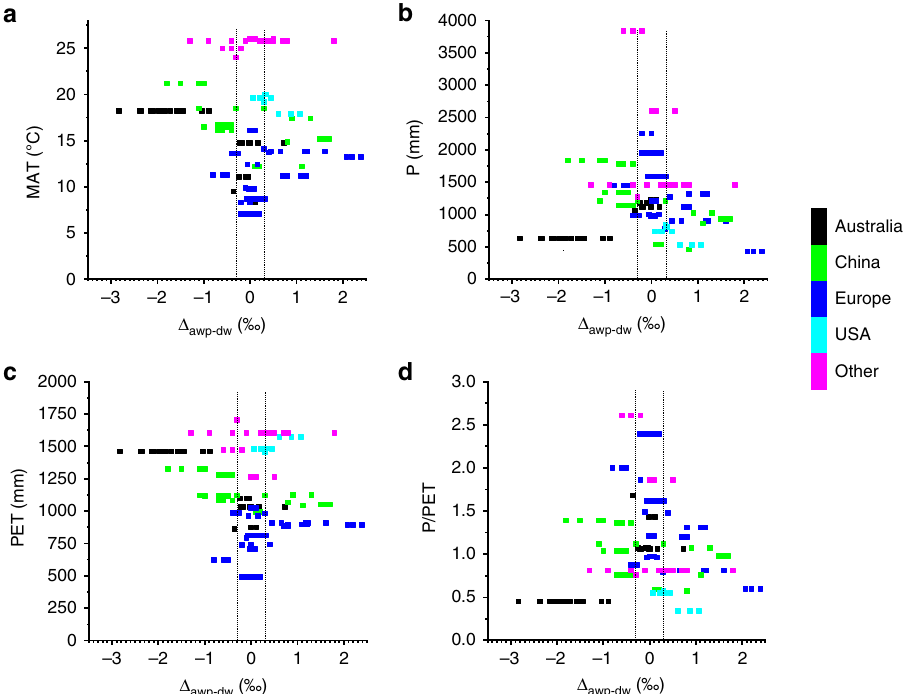
Fig. 3 The global relationship between Δ awp-dw and climate parameters. a Mean annual temperature (MAT), b total annual precipitation (P), c total annual potential evapotranspiration (PET), and d mean annual potential evapotranspiration relative to mean annual precipitation (P/PET). Colours represent different regions: Australia (black), China (green), Europe (blue), United States (cyan) and all other regions (magenta). Black vertical lines show the 0.3 ‰ criterion for determining the signi fi cant difference between δ 18 O amountwprecip and δ 18 O